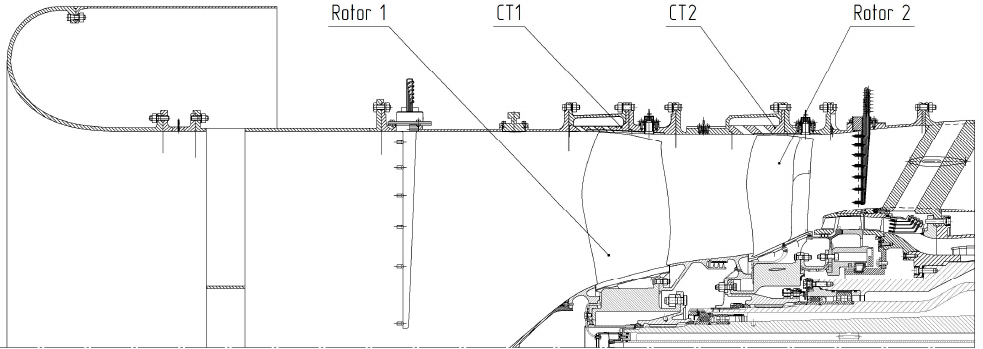
Figure 28. Counter rotating fan with different types of casing treatments (CT).